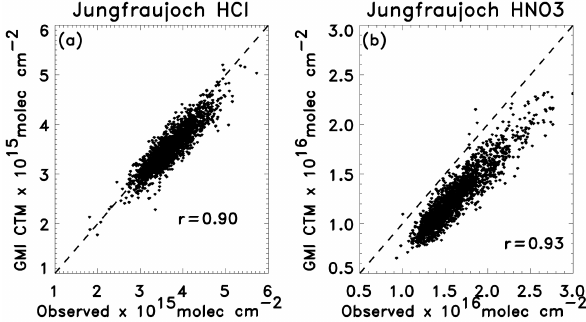
Figure 5. Simulated and observed columns 1989–2014 for (a) HCl and (b) HNO 3 . Both simulated species are highly correlated with the observations when the simulation is sampled for the location and days of the measurements.